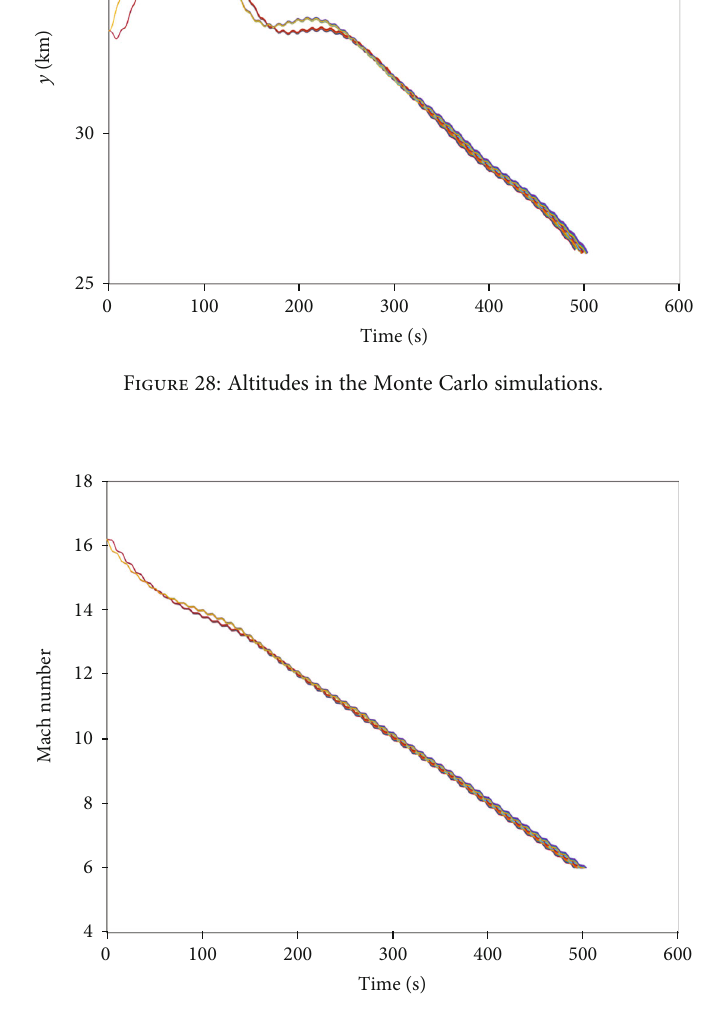
Figure 29: Mach numbers in the Monte Carlo